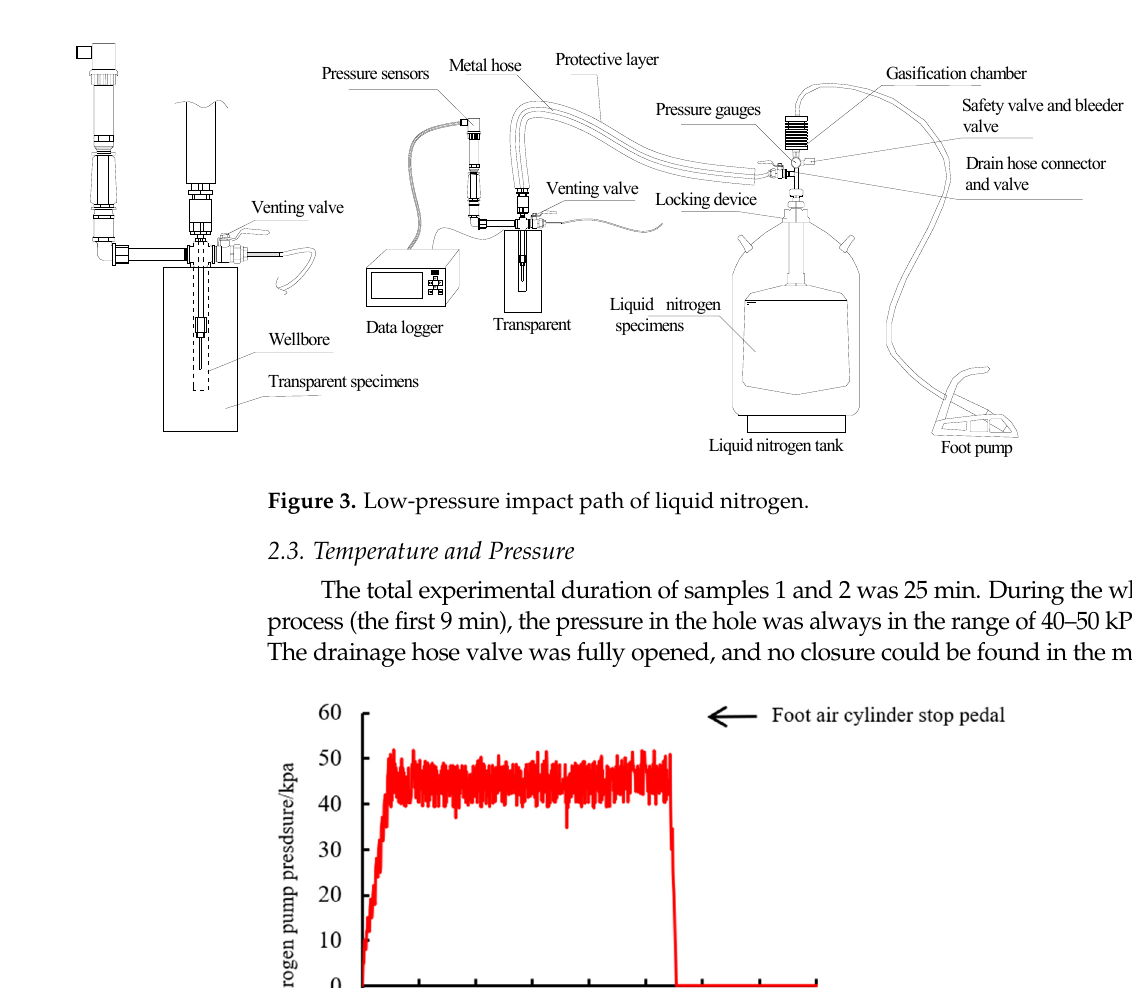
Figure 3. Low-pressure impact path of liquid nitrogen.